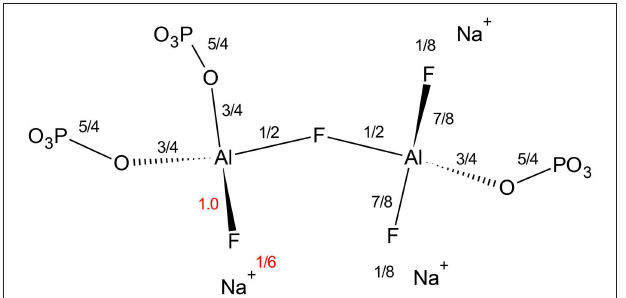
FIGURE 8 | Effect of increasing fluoride on Al[4]—F—Al[4] bond in Al/P ratios of 0.67 (right side) and 1.0 (left side) environment. We are assuming all terminal fluorines have one coordinated Na + .